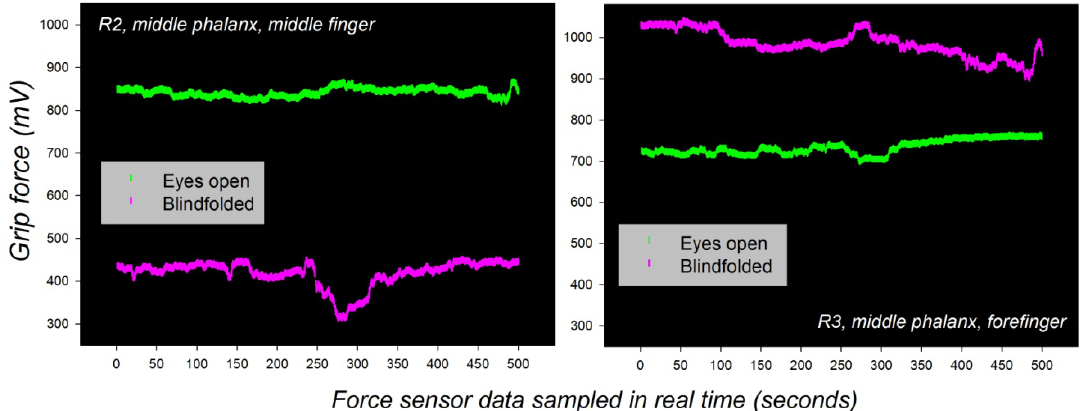
Figure 5. Spontaneous adaptive reorganization of an individual’s grip force profile (dominant hand) during a bimanual grip task executed first blindfolded, and then with both eyes open. Unpublished data from a study described in [106] are shown. Gross grip force in the middle finger spontaneously increases with sudden visual input (left), while simultaneous grip force in the forefinger decreases